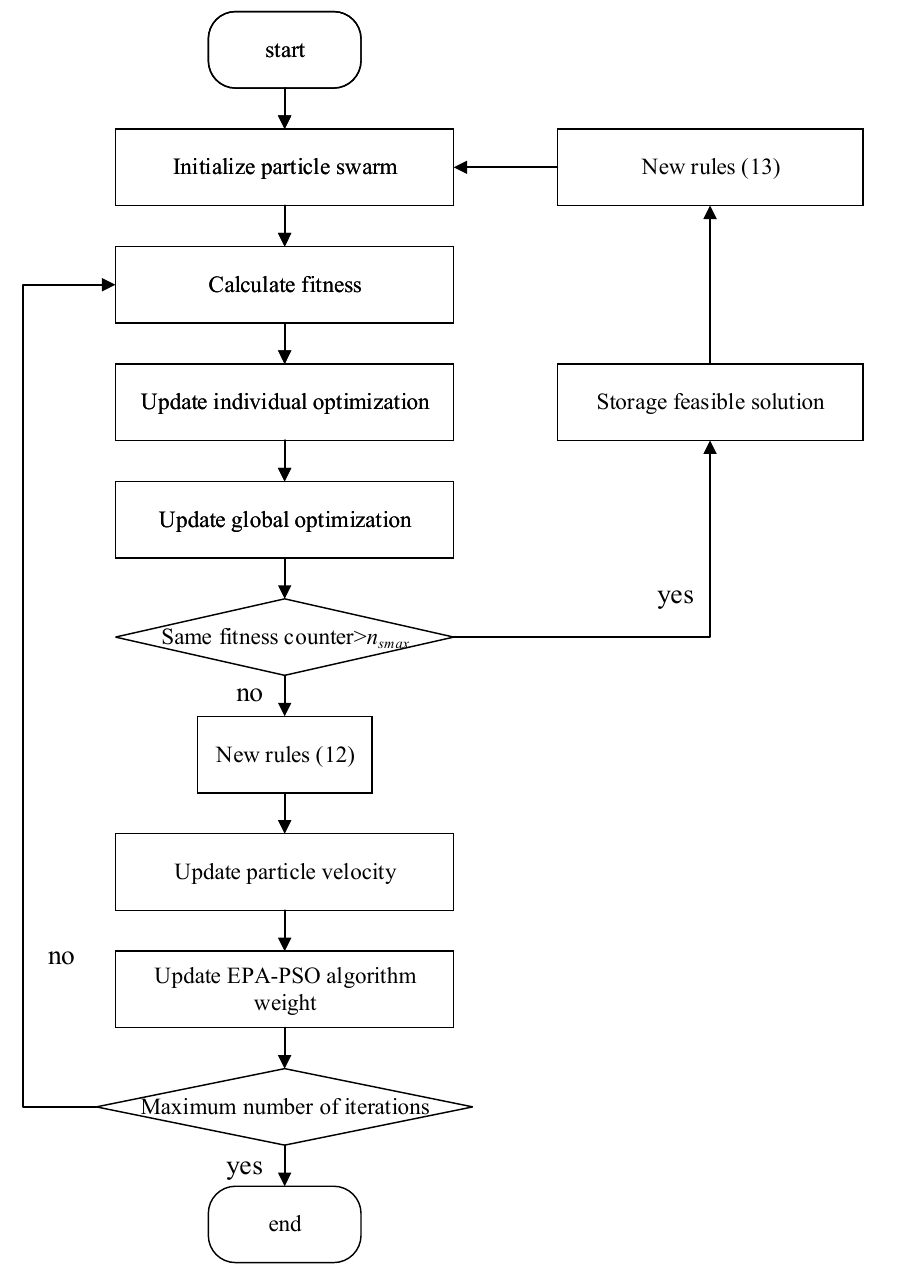
Figure 2. Steps of EPA-PSO algorithm.